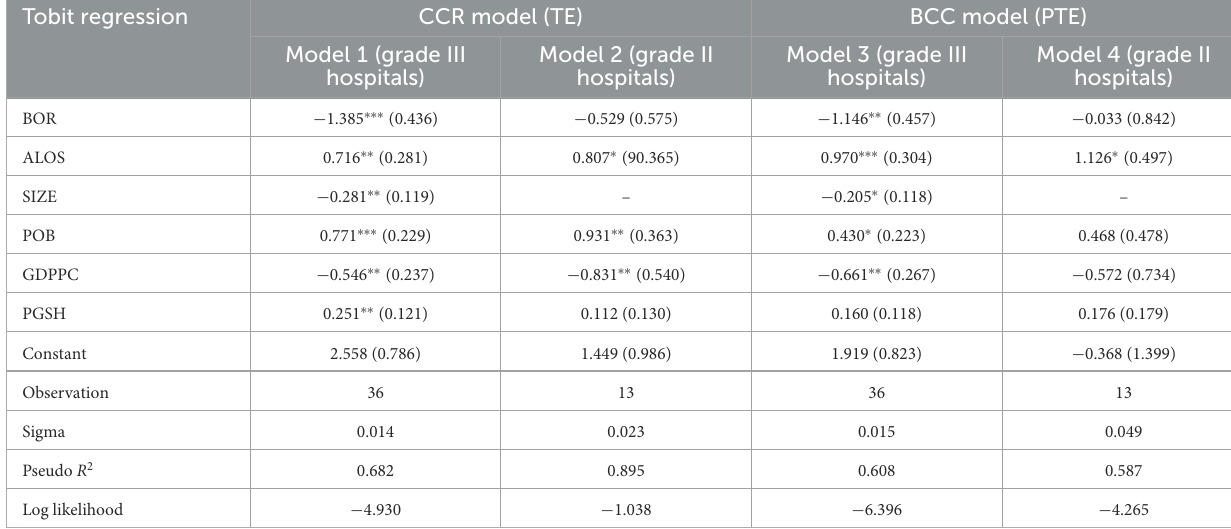
TABLE 10 Tobit regression of DEA-CCR and DEA-BCC models.